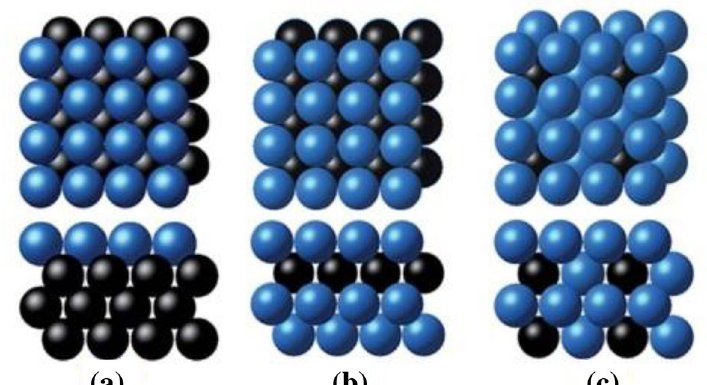
Figure 3. The {100}-terminated alloy surfaces in the form of ( a ) B@A, ( b ) AB@A, and ( c ) A3B@A. The first rows indicate the top view, and the second rows show the side view of the structures 42